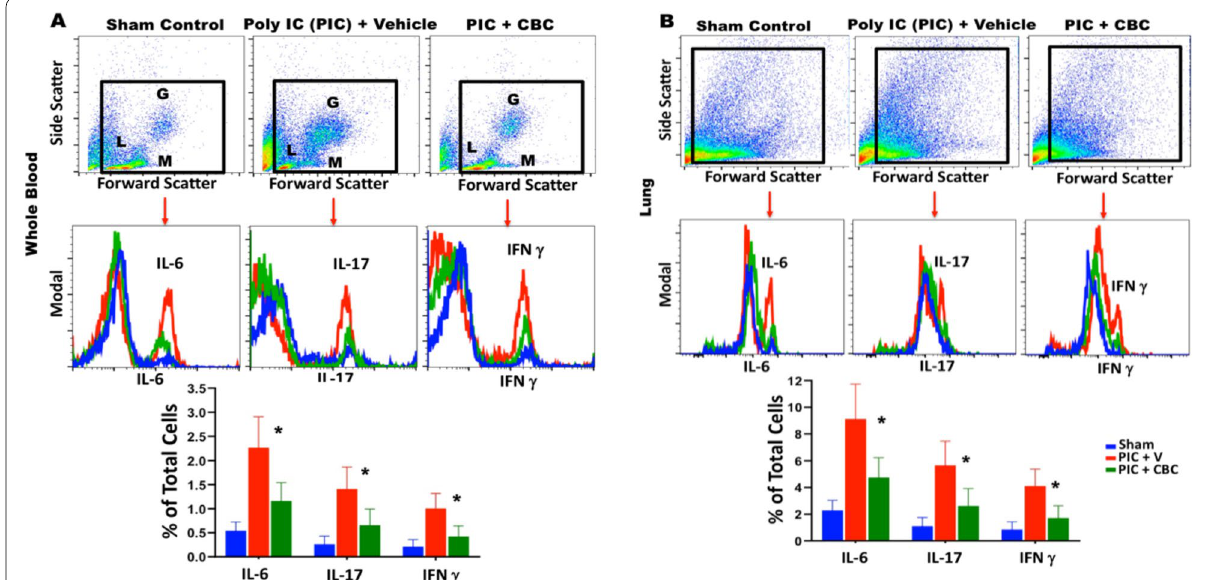
Fig. 3 Inhalant cannabichromene (CBC) reduced ARDS-like induced inflammatory indices. Flow cytometry analysis of A whole blood and B lung tissues showed that Intranasal administration of Poly(I:C) effectuated a significant increase of pro-inflammatory cytokines including IL-6, IL-17, and IFNγ (PIC group) compared to the control group (sham). These effects were reversed with inhalant CBC (PIC downregulation of all three pro-inflammatory cytokines (* p <0.03, means group showed increased granulocytes (G) and monocytes (M) while lymphocytes were decreased compared to mice treated with inhalant CBC (PIC CBC) supporting the notion that inhalant CBC can reverse the adverse effects of ARDS and re-establish the immune balance, resolving + lymphopenia and restoring